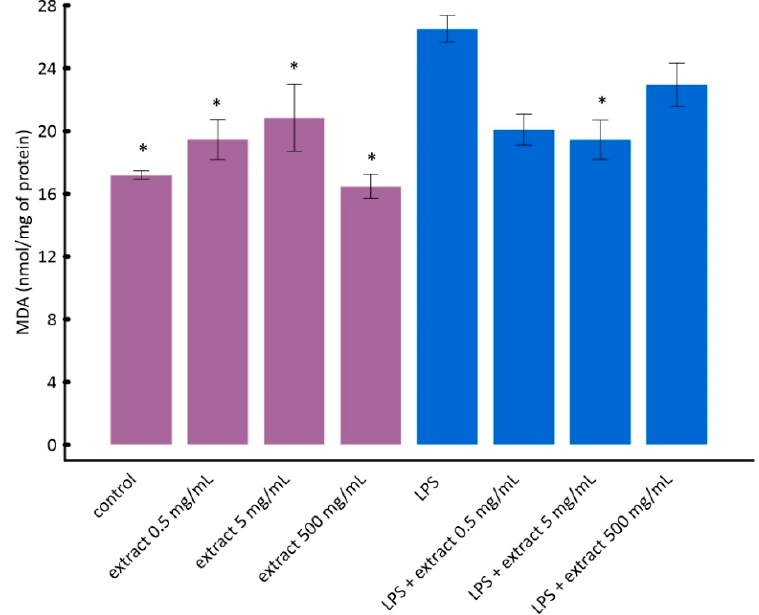
Figure 4. The influence of aronia extract on lipopolysaccharide-induced lipid peroxidation. The values are means ±SD. Results for samples marked with * do not differ statistically from control cells at p < 0.05.